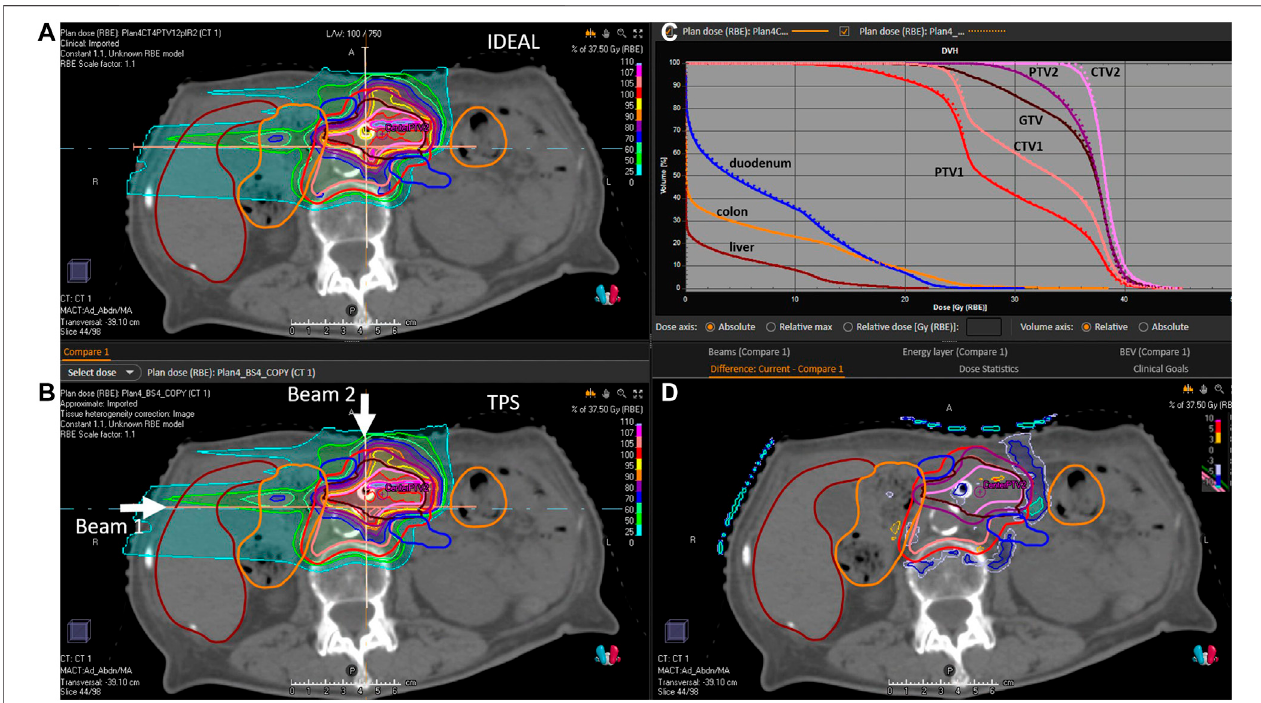
FIGURE7| P1evaluation. (A) :2DIDEALdosedistributioninaCTslice(transversalview), (B) :2DTPSdosedistributioninaCTslice(transversalview), (C) :1Ddose volumehistogramsextractedfrom the3DIDEAL and TPSdosedistributions(fullline (cid:1) IDEAL, dottedline (cid:1) TPS), (D) :2Ddose differencein aCTslice extracted from the 2D IDEAL and TPS dose distributions presented on the (A,B) (IDEAL — TPS). Beam directions are represented on the (B)